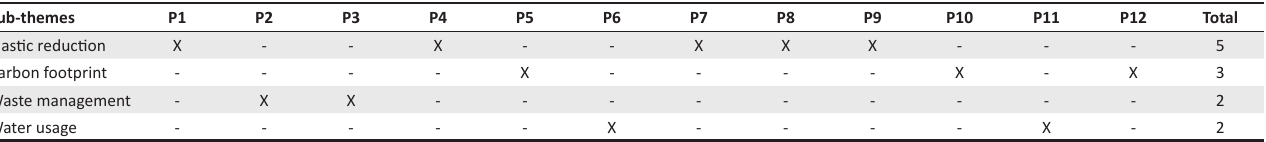
TABLE 2: Predominant environmental initiatives identified by respondents.